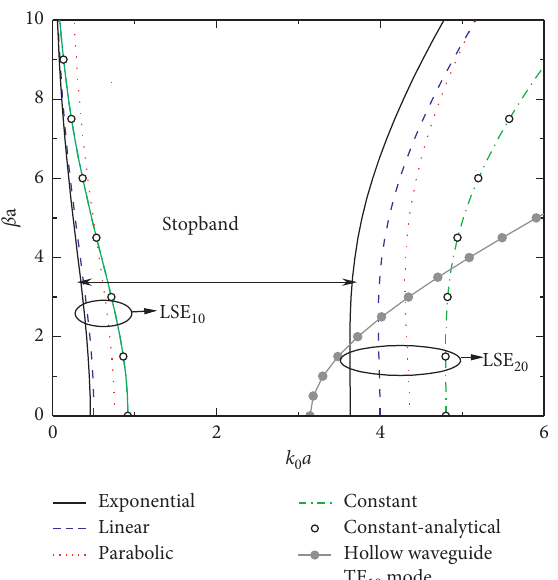
Figure 4: The dispersion relations of the CRLHM-filled rectangular waveguide’s LSE modes for exponential, linear, parabolic, and constant profiles and the dispersion relation of the TE 10 modes of a hollow rectangular waveguide with the same dimension, d � 2 .